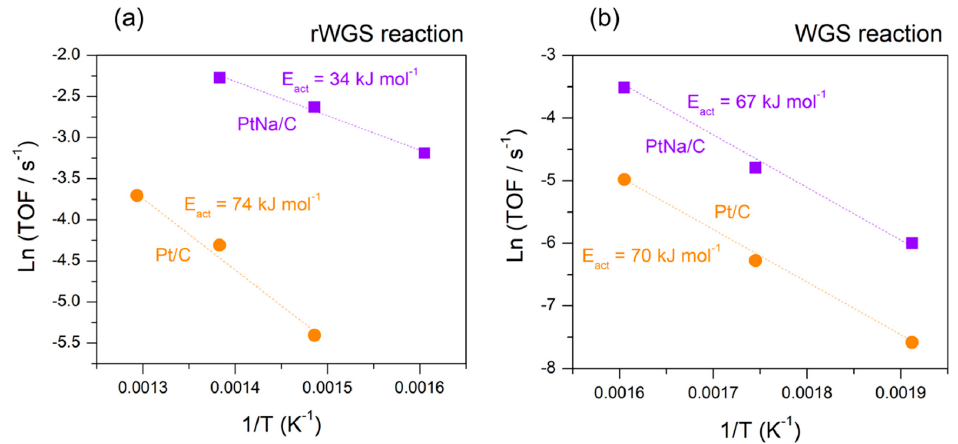
Figure 10. Arrhenius-type plots for both catalysts obtained in ( a ) rWGS and ( b ) WGS reactions.